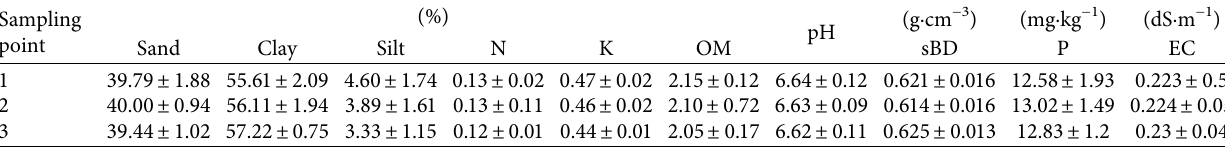
Table 1: The mean values of the physicochemical properties.